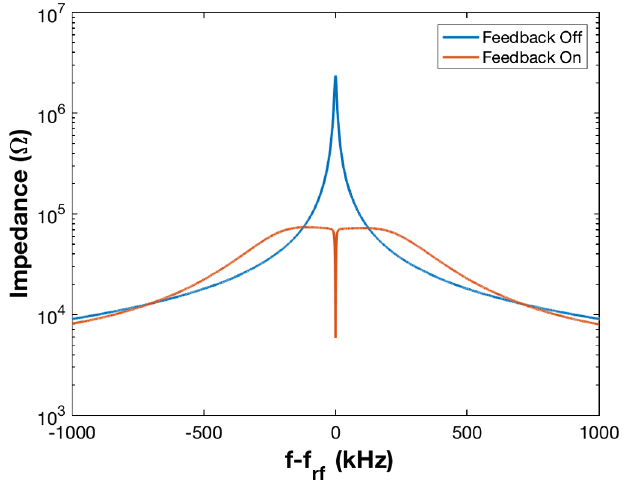
FIG. 3. Modulus of cavity impedance with and without rf feedback. Injection settings: Q L ¼ 20000 , V c ¼ 1 MV, cavity on tune.